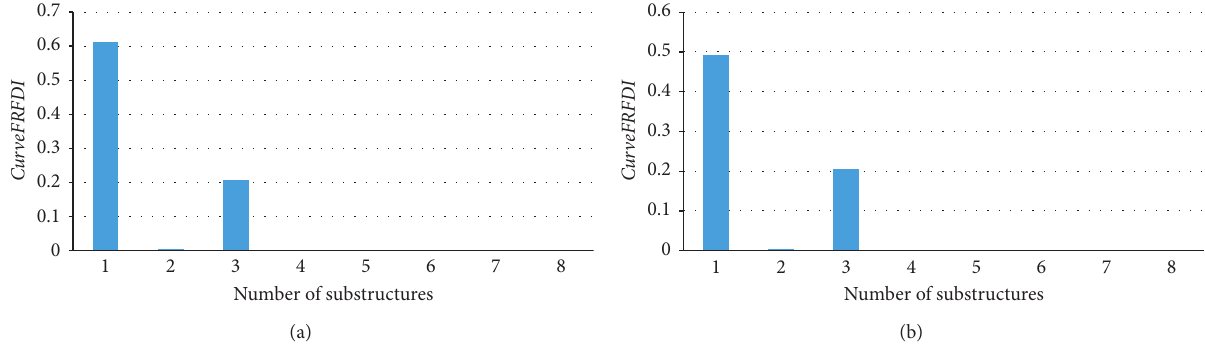
Figure 35: CurveFRFDI values of DIC-measured data for (a) case Dam200_1F&3F and (b) case Dam500_1F&3F.